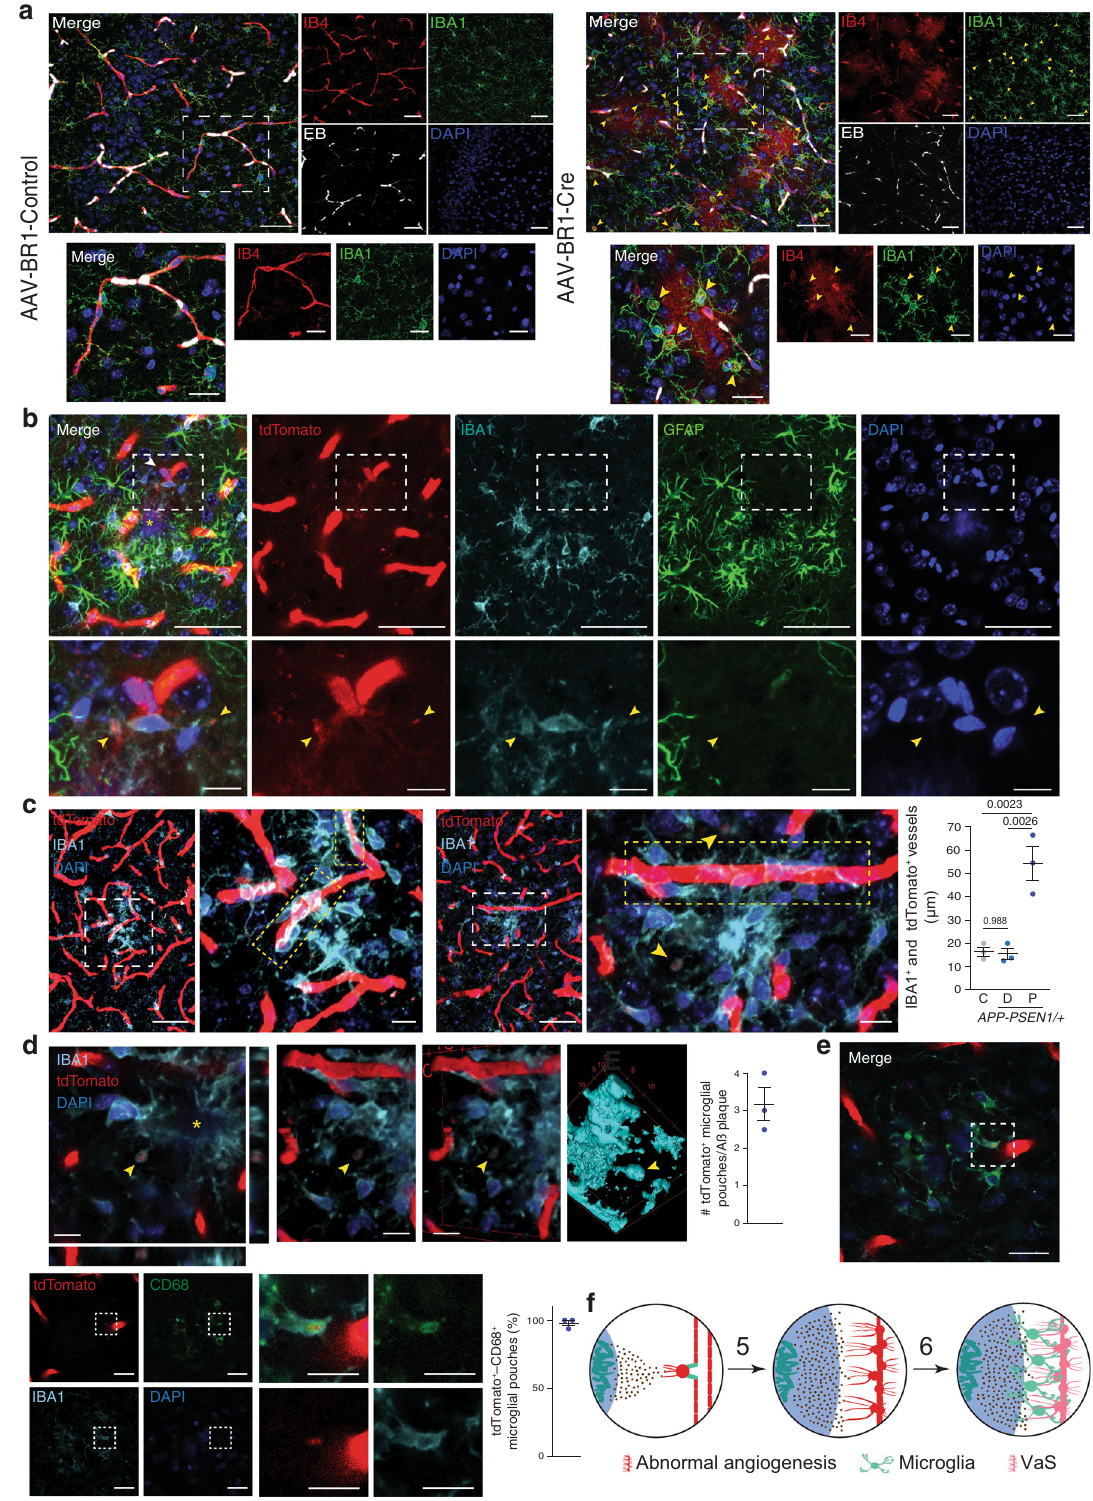
Interestingly, NPA induction ( γ -secretase genetic inhibition) in adult endothelial cells is suf fi cient to produce identical IB4 + VaS in the absence of amyloid pathology. In the human AD brain, (i) BBB disruption has been mapped to Aß-depositing areas that show brain parenchymal accumulation of blood-derived immu- noglobulin G and Fibrin 17 , (ii) microhemorrhages are a frequent characteristic of Aß plaques 48 , (iii) Aß plaque-associated vascular